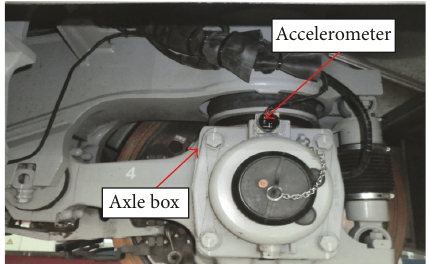
Figure 16: Location of accelerometer on the axle box.